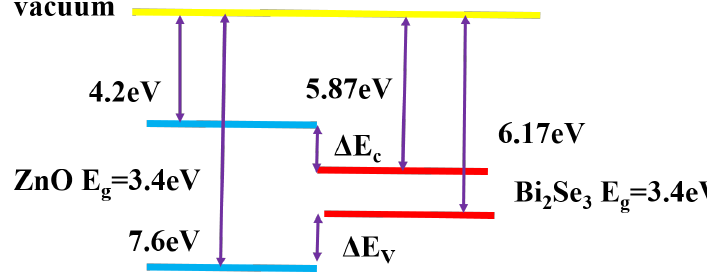
Figure 5. Electronic band alignment for Bi 2 Se 3 /ZnO NWAs structure.